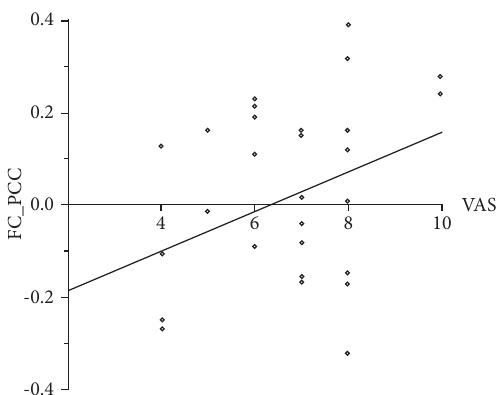
Figure 4: The decreased functional connectivity between the left middle frontal cortex and posterior cingulate cortex in MwoA-DI patients compared with HCs was positively associated with MwoA- DI patients’ VAS ( p � 0 .